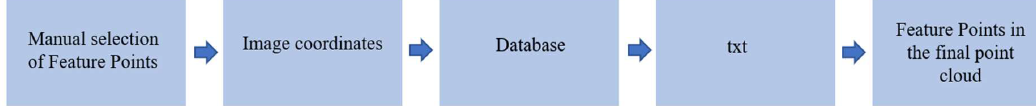
Figure 5 . Workflow used for the creation of the 3D representation of the lost structures.